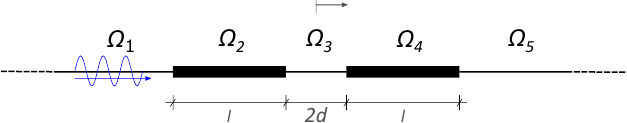
Figure 3. One-dimensional counterpart of the two-dimensional homogenized problem. The system is simplified by fixing a position along the x 2 axis and by considering x 1 = x . The dashed ends are used to indicate that the domain is infinitely extended toward − ∞ and + ∞